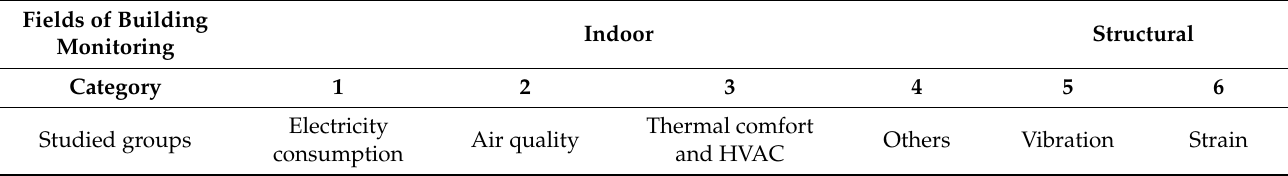
Table 3. Defined categories for the two main fields of building monitoring.